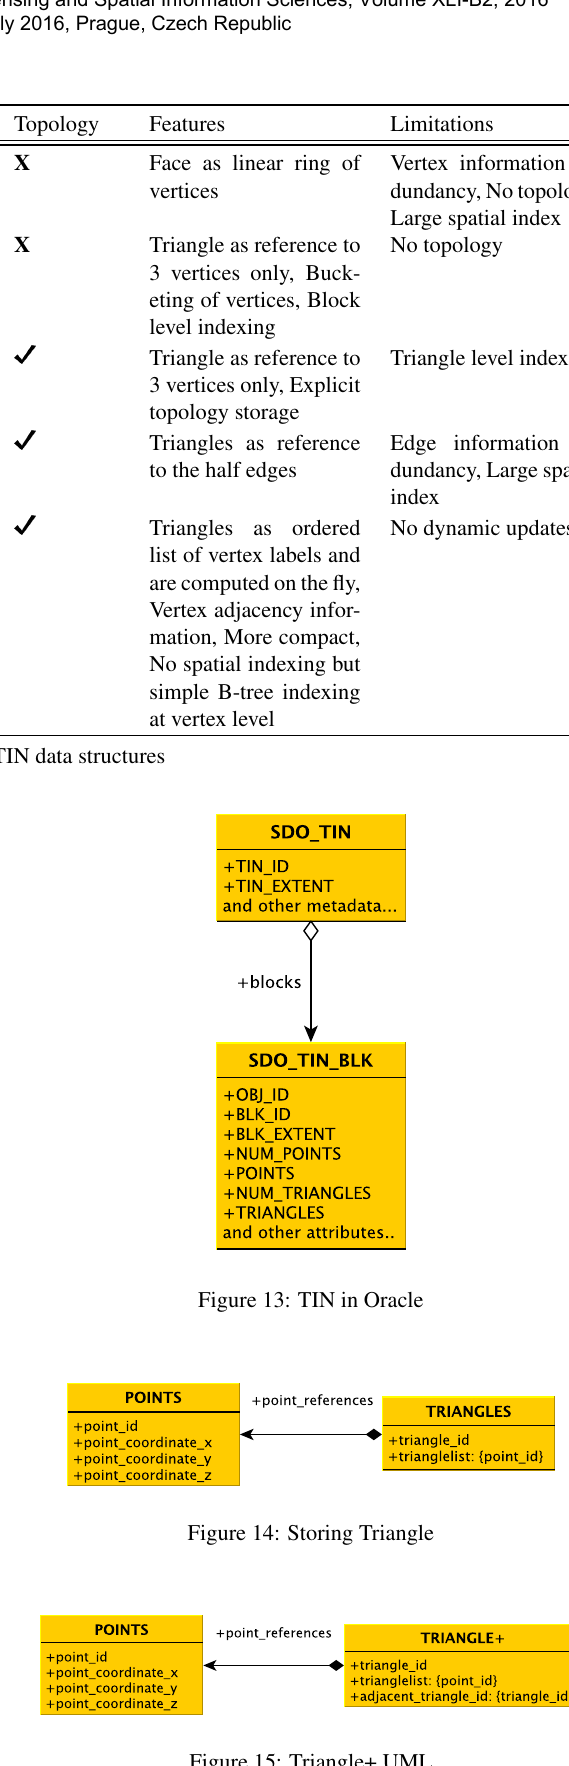
Figure 15: Triangle+